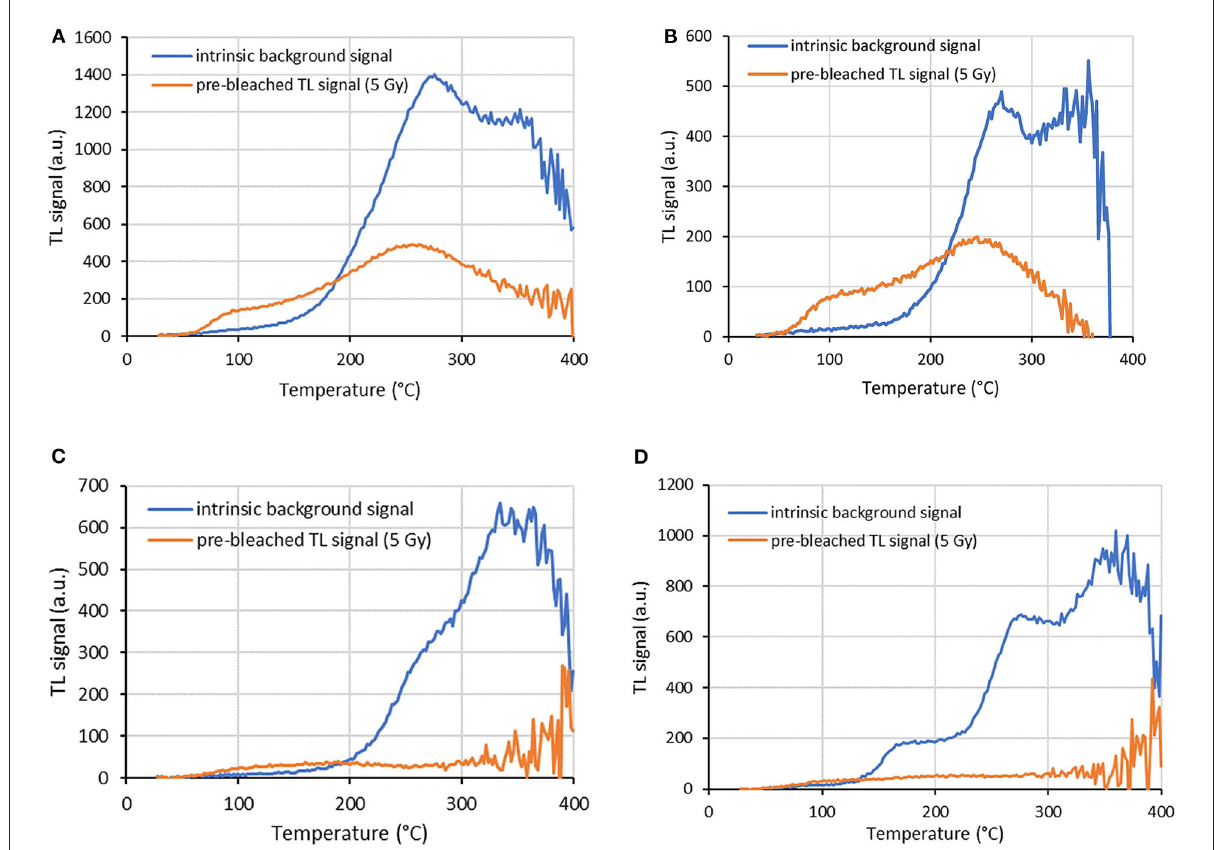
FIGURE1 Intrinsic background signal of an aliquot of each screen protector investigated. Pre-bleached radiation-induced TL signal of 5Gy is also shown. TL signals are normalized to aliquot mass. Screen protector ID: (A) P4, (B) P5, (C) P6, (D)